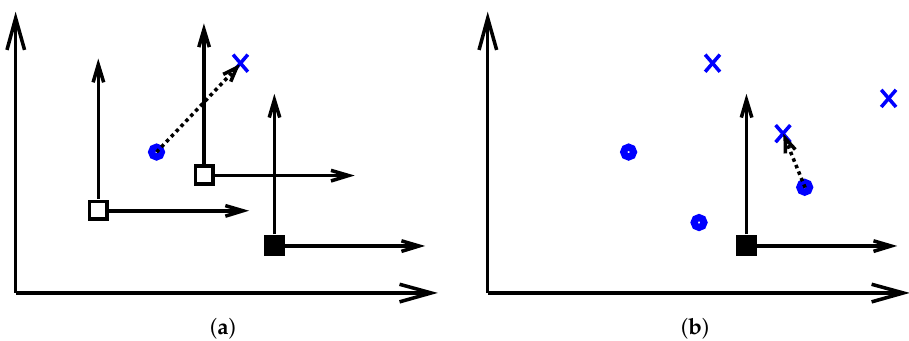
Figure 2. In ( a ), two manifold points appearing in the tangential spaces at three equivalent manifold points (the square ones). It shows the displacement vector between the two points. In ( b ), the original two points and their images under the equivalency are shown with respect to the reference tangential space (the solid square). The invariant displacement vector under the equivalency is also